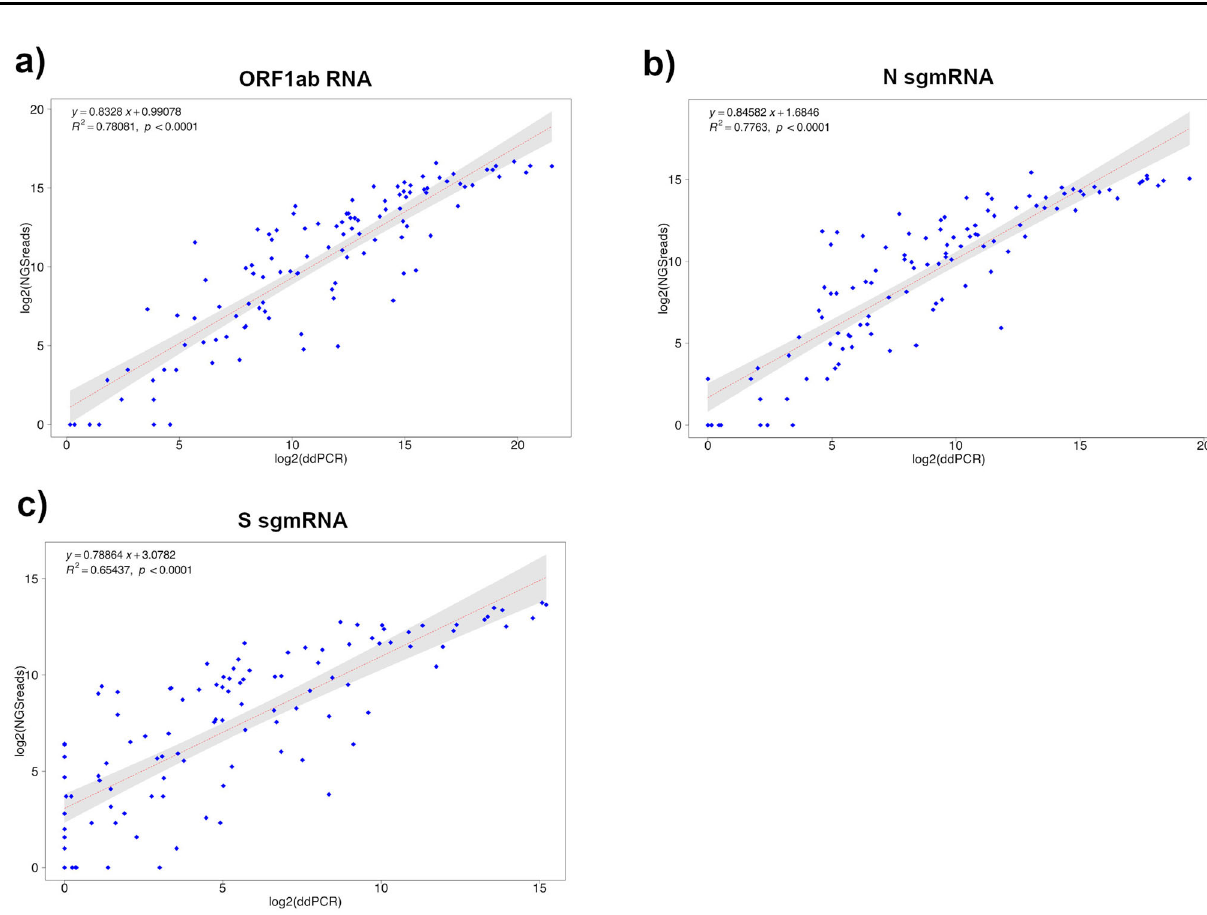
Fig. 3 Correlation between ddPCR and transcriptomics data for SARS-CoV-2 ORF1ab, N and S sgmRNA targets. Linear correlation between ddPCR and sequencing quanti fi cation of SARS-CoV-2 ORF1ab gRNA ( a ), N sgmRNA ( b ), and S sgmRNA ( c ) calculated on 110 SARS-CoV2 positive RNA samples, by means of a bivariate linear fi t analysis ( p- value < 0.0001). On X -axis: log2 scaled ddPCR quanti fi cation; on Y -axis: log2 scaled meta-transcriptomics reads count. The regression equation and R 2 are reported in the top-left corner. The gray area represents a 0.95 level of con fi dence